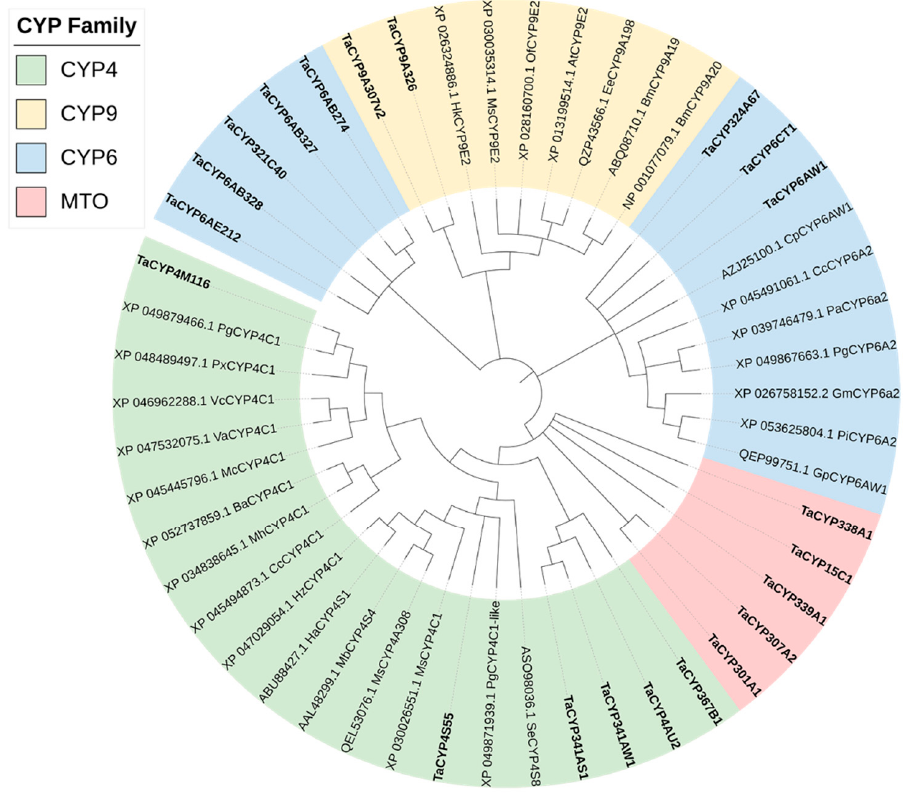
Figure 4. Phylogenetic analysis of 21 P450 genes of T. absoluta and related species’ P450s. Amino acid sequence source: Pg, Pectinophora gossypiella, Vc, Vanessa cardui, Px,